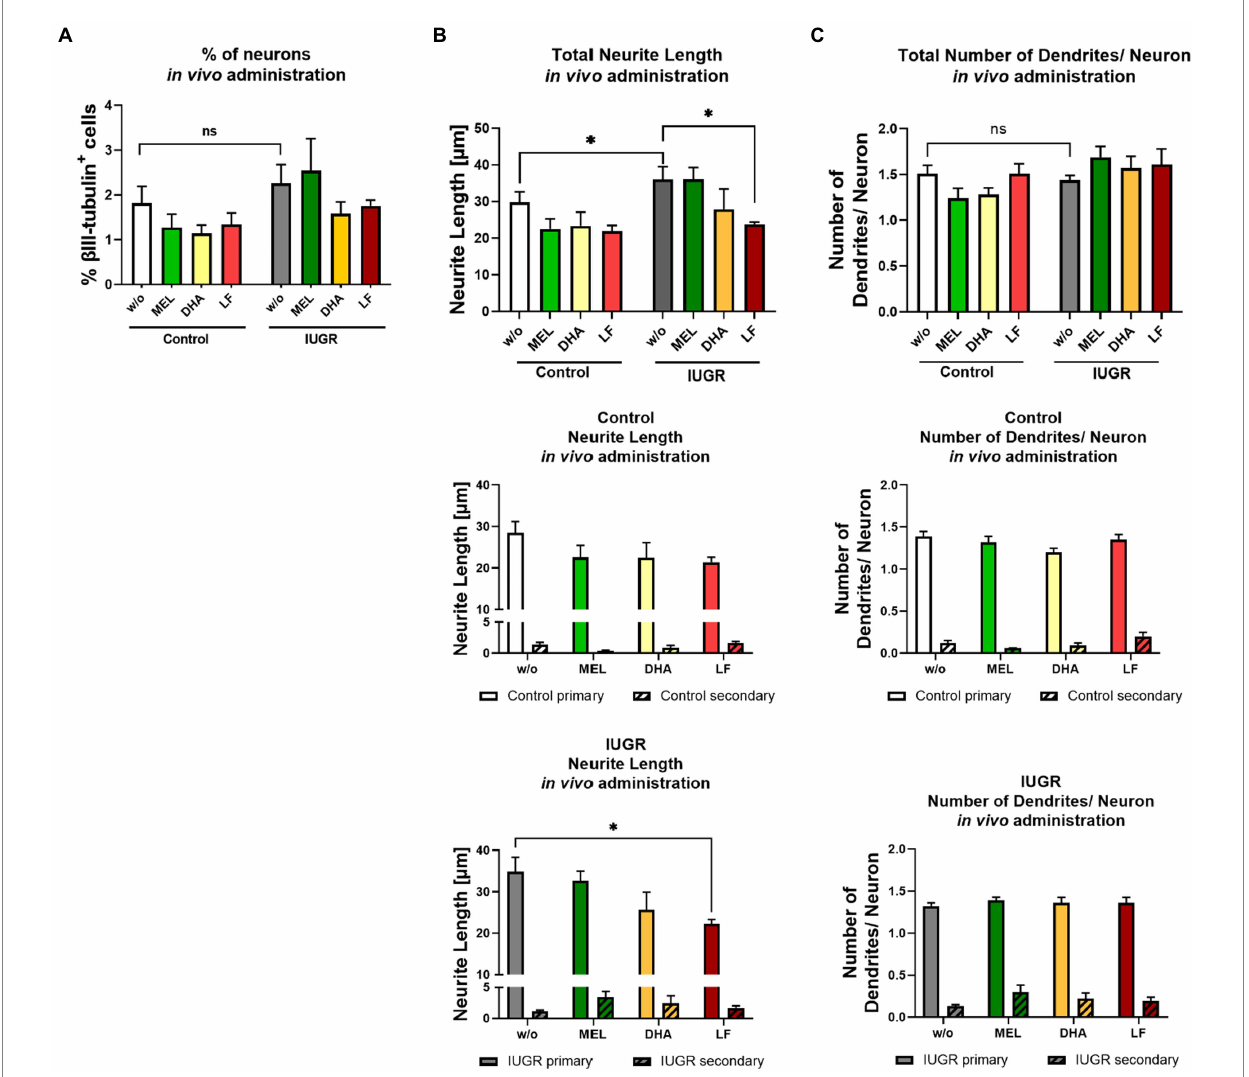
FIGURE 7 Administration of potential therapies in vivo – evaluation after 5 days in vitro . Pregnant rabbits received no treatment (w/o), MEL (10 mg/kg bw/day, green), DHA (37 mg/kg bw/day, yellow) or LF (166 mg/kg bw/day, red) at the day of IUGR induction until cesarean section. Neurospheres obtained from Control and IUGR pups were tested for (A) % neuronal differentiation (% β III-tubulin+ cells), (B) total neurite length and below length of primary and secondary dendrites in control and IUGR neurospheres (C) total number of dendrites/ neuron and below number of primary and secondary dendrites in control and IUGR neurospheres; Mean ± SEM; * p ≤ 0.05, ns: not significant. Upper row: Data was analyzed using one-way ANOVA. Comparison of more than two groups (treatment, primary and secondary dendrites) was assessed by two-way ANOVA. Both followed by Bonferroni’s multiple comparison